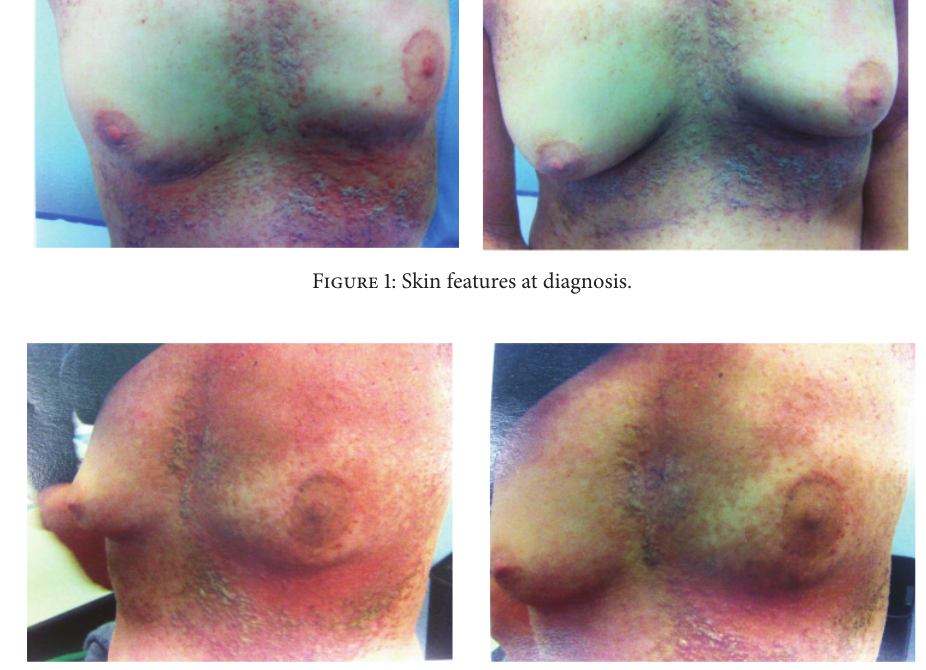
Figure 2: Skin features during radiation